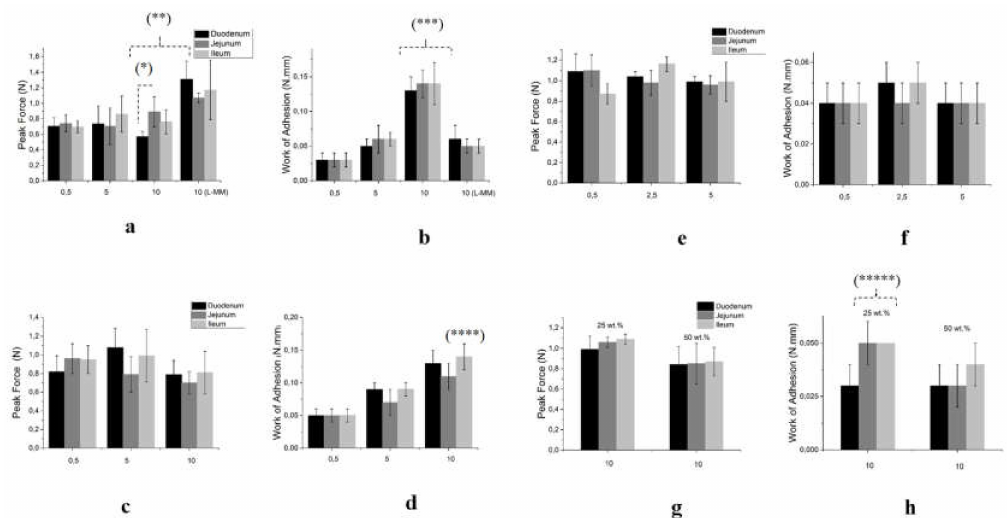
Figure 4. Mean values of the mucoadhesion parameters of the structures in the intestinal segments. ( a , b ) I-MM peak force and work of adhesion, ( c , d ) H-MM peak force and work of adhesion ( e , f )